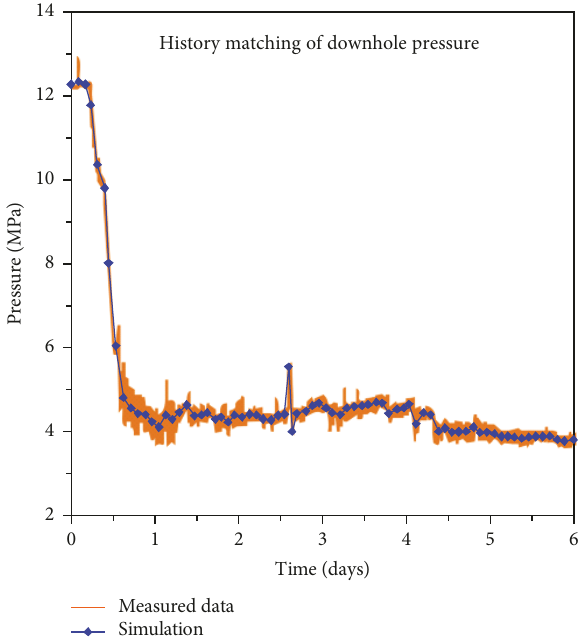
Figure 7: Depressurization processes of the production test at the AT1 site in the Eastern Nankai Trough.